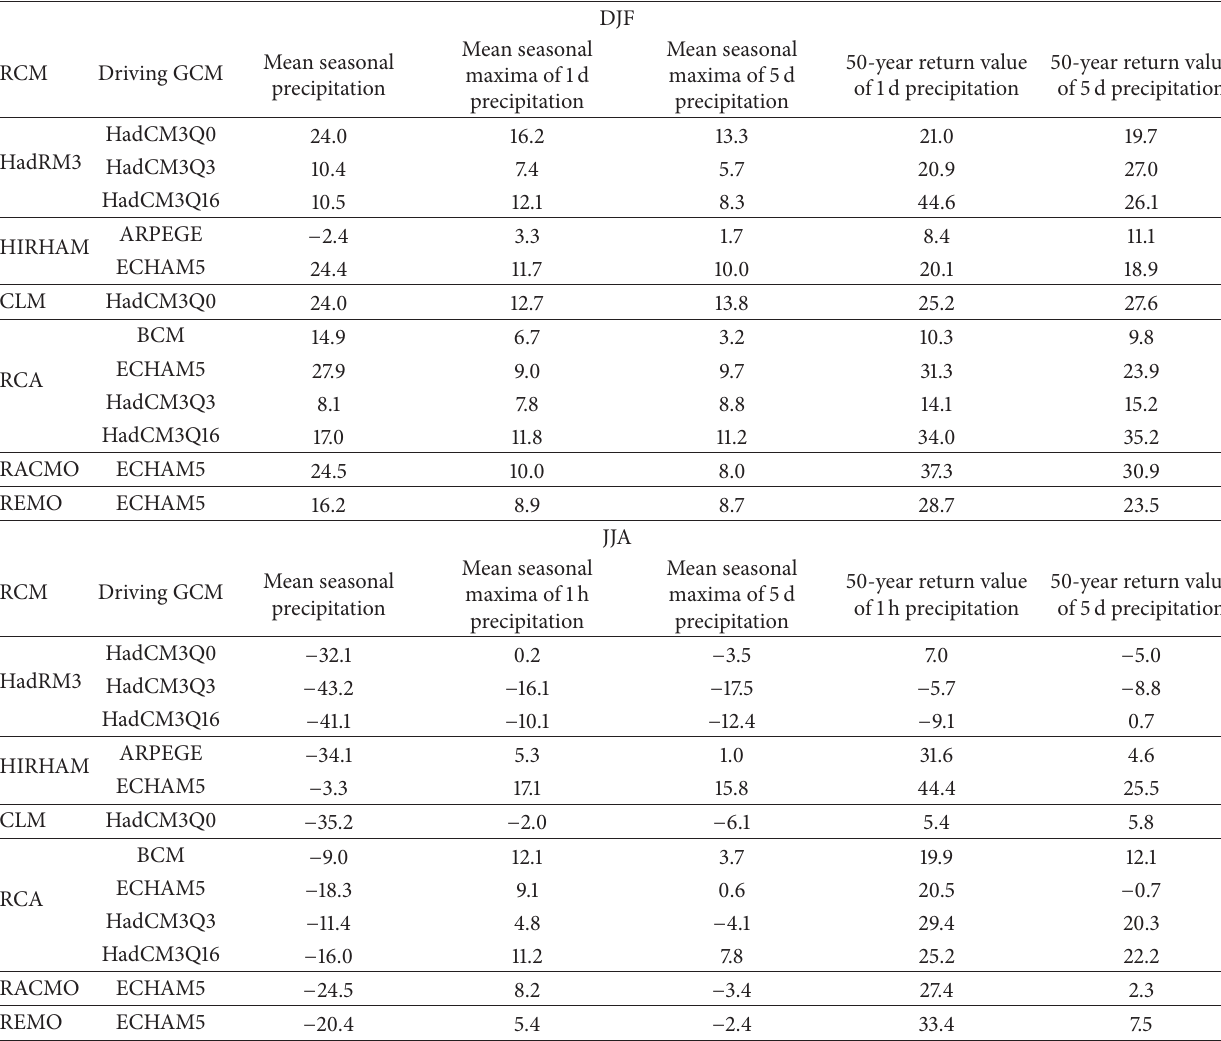
Table 3: Average relative changes (in %) of mean seasonal precipitation totals, mean seasonal maxima, and 50-year return values of 1-hour/1- day and 5-day precipitation amounts in the Carpathian Basin (lon. 17–28 E, lat. 44.5–50.5 N) between 2070–2099 and 1961–1990.